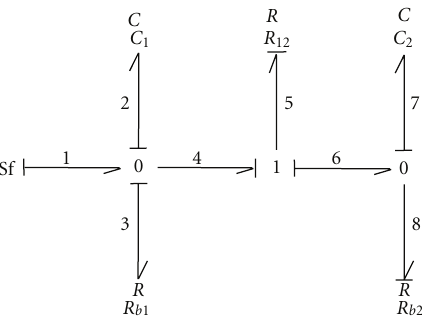
Figure 4: Bond graph of a bitank